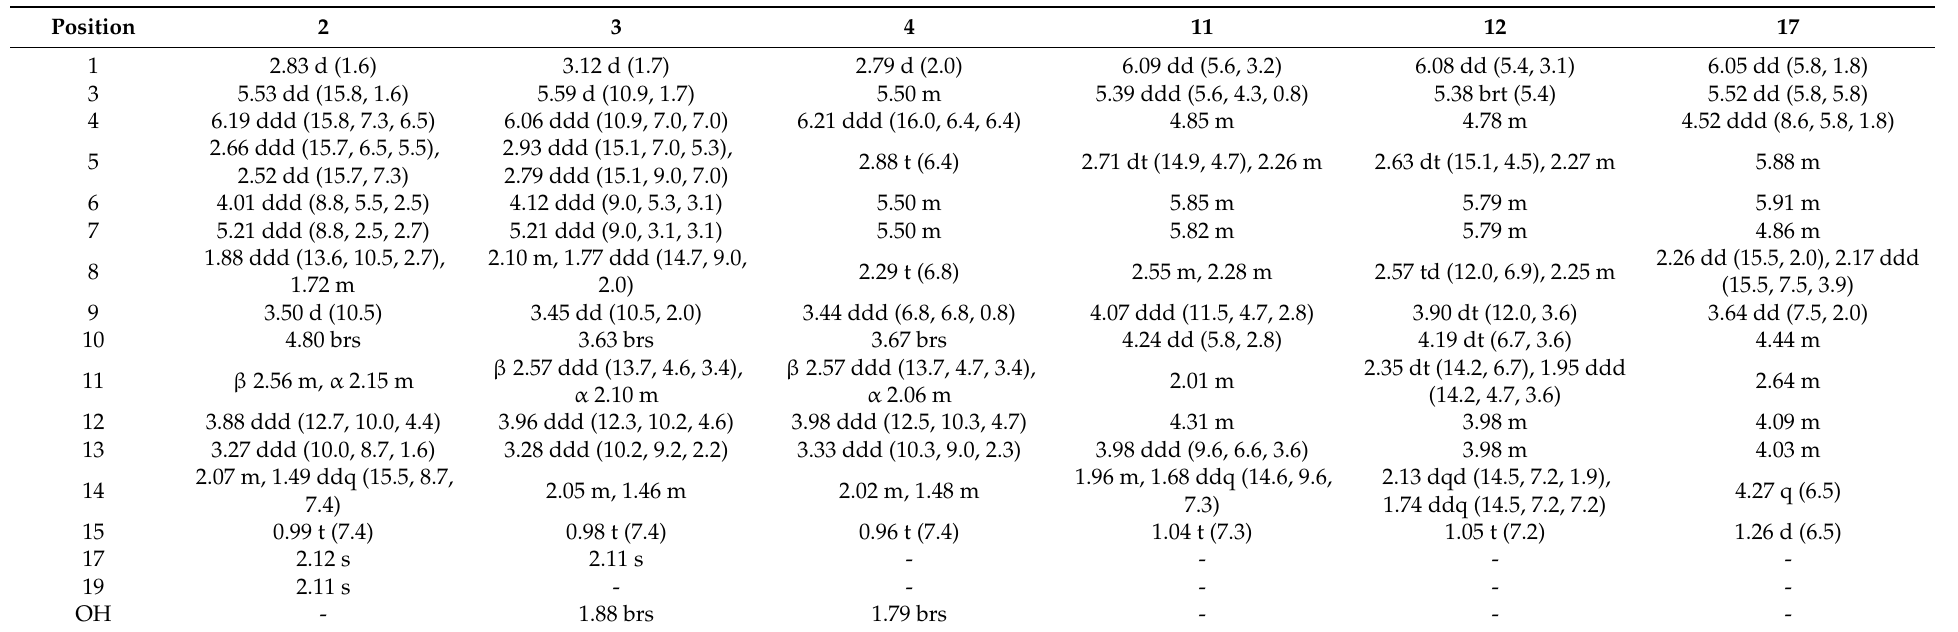
Table 2. 1 H NMR ( δ in ppm, J in Hz) data of compounds 2 , 3 , 4 , 11 , 12 and 17 recorded at 400 MHz in CDCl 3